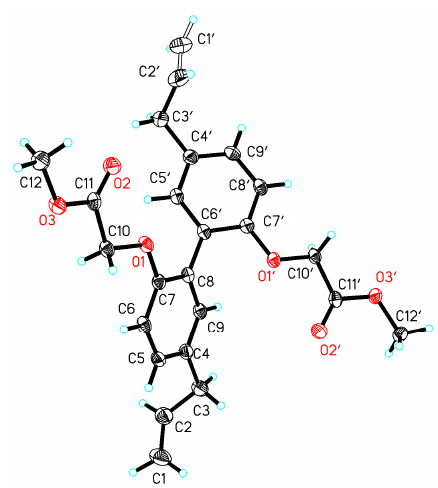
Figure 3. X-ray ORTEP (Oak Ridge Thermal Ellipsoid Plot) drawing of coampound 7b .